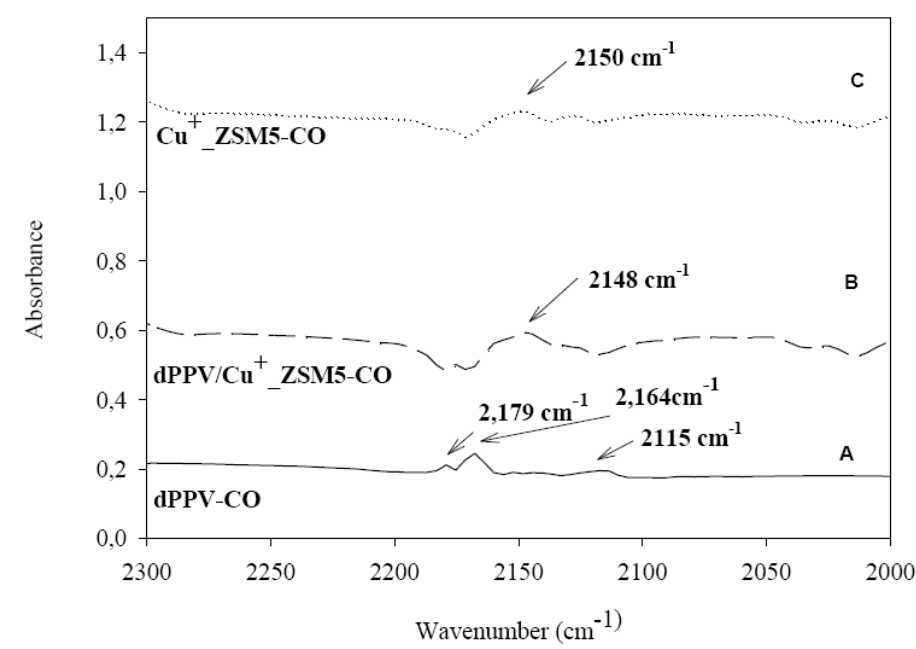
Figure 6. IR spectra of CO (pressure at 1 atm and at room temperature adsorbed on: (a) doped PPV; (b) doped PPV/Cu + -ZSM5; and (c) Cu +